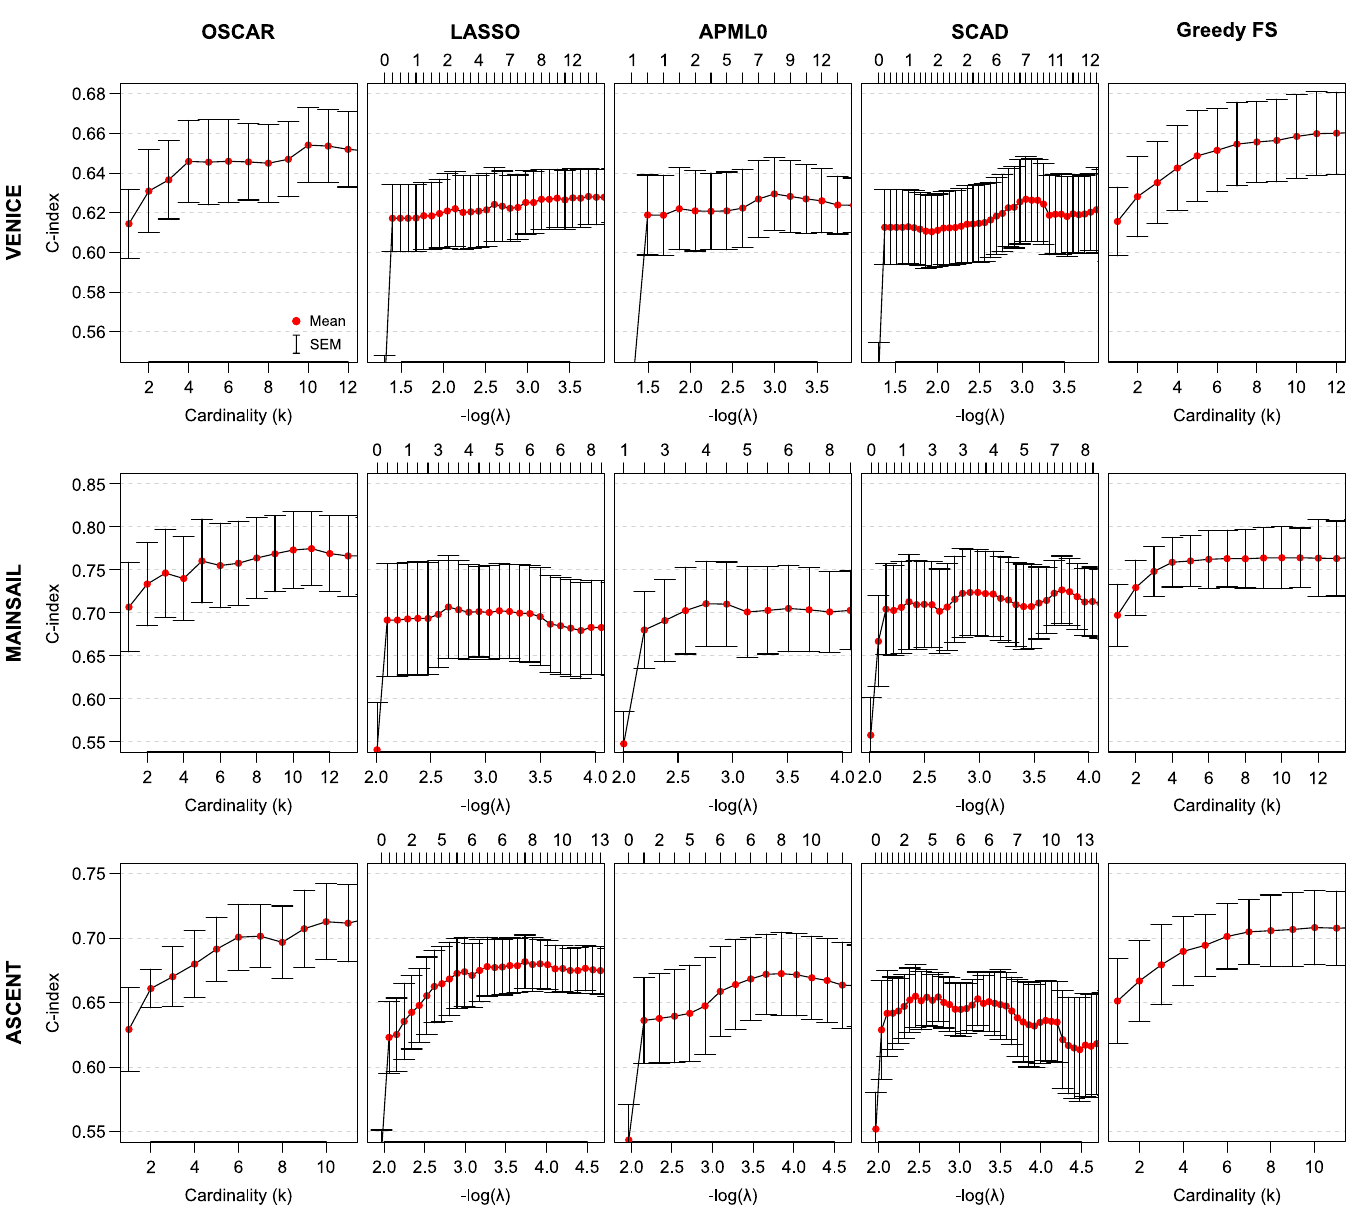
Fig 7. First panel: CV performance of OSCAR in the three trial cohorts. Second panel: CV performance of LASSO in the three trial cohorts. Third panel: CV performance of APM- L 0 in the three trial cohorts. Fourth panel: CV performance of SCAD in the three trial cohorts. Fifth panel: CV performance of Greedy FS in the three trial cohorts. The red dots denote the mean values and the error bars denote the standard errors of the mean (SEM) calculated over the CV folds.